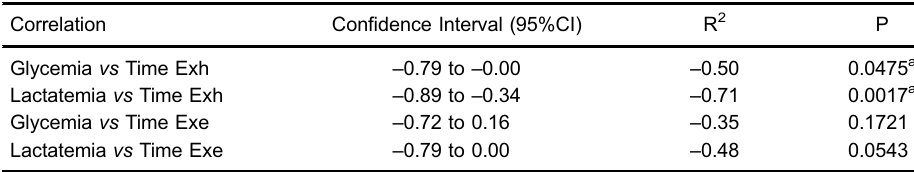
Table 2. Correlation analysis between forced swimming (Exe group) or forced to swim up to exhaustion (Exh group) and glycemia or lactatemia.